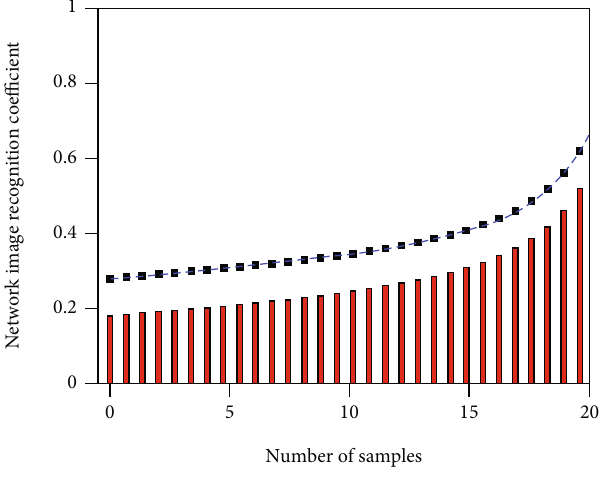
Figure 5: Distribution curve of public opinion recognition degree of network